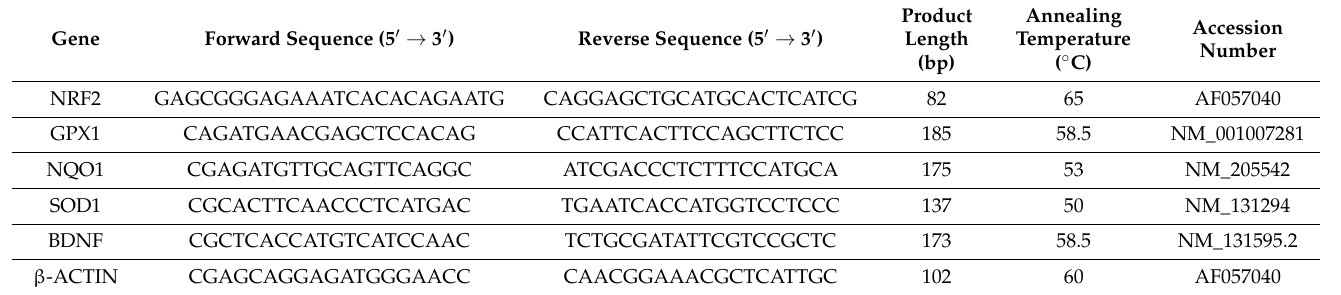
Table 1. Primer sequences used, and the expected product size of target genes in the RT-PCR reaction.